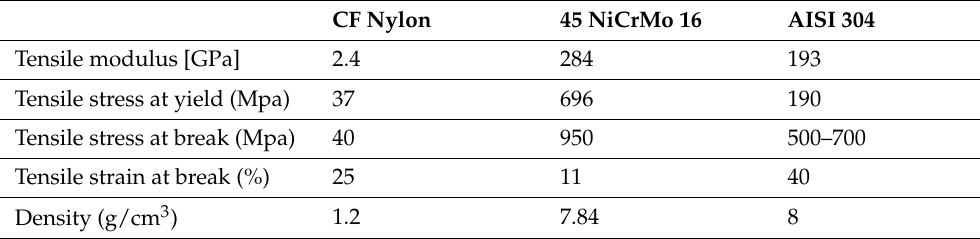
Table 2. Mechanical properties of punches, forming dies and